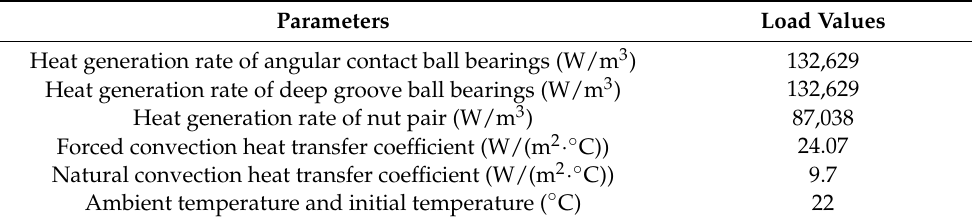
Table 4. Load values of boundary